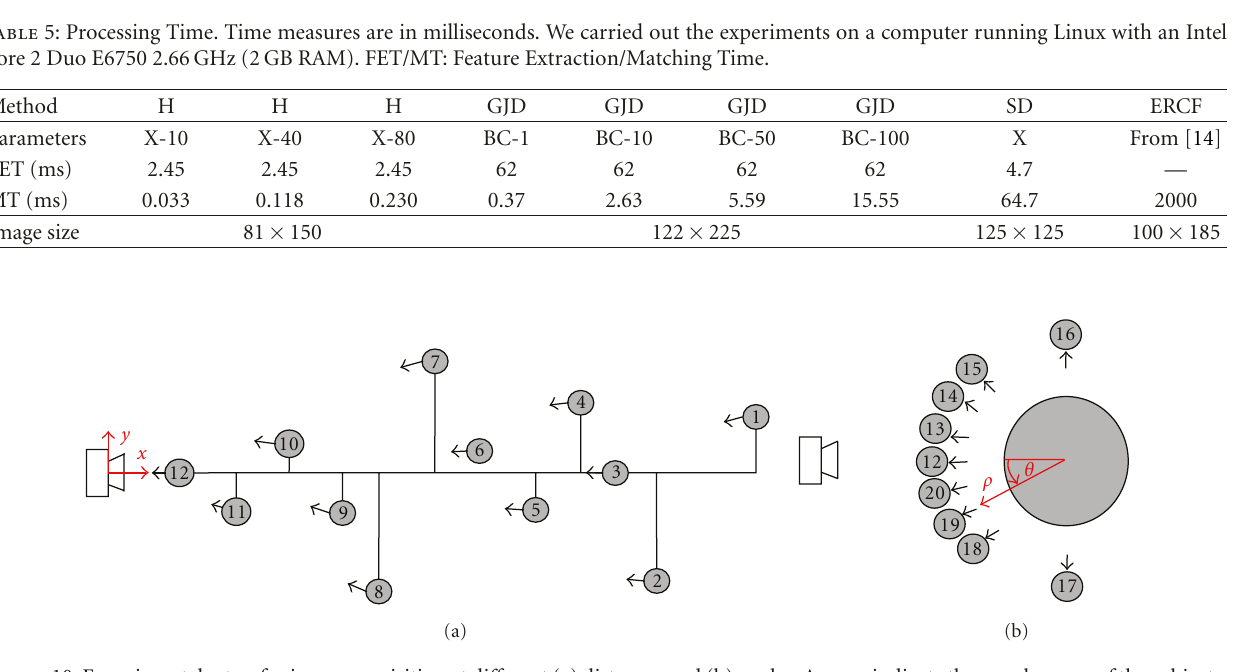
Figure 10: Experimental setup for image acquisition at di ff erent (a) distances and (b) angles. Arrows indicate the angular pose of the subjects. (a) Cartesian coordinates of acquisition points (in centimetres) relative to the camera’s focus: P1 (1088,90), P2 (906, − 180), P3 (785,0), P4 (755,151), P5 (665, − 51), P6 (574,30), P7 (514,181), P8 (423, − 181), P9 (332, − 61), P10 (272,30), P11 (181, − 61), and P12 (90,0). (b) Polar coordinates of acquisition points (radius in centimetres and angles in degrees) relative to the camera’s focus: P16 (90,90 ◦ ), P15 (90,45 ◦ ), P14 (90,30 ◦ ), P13 (90,15 ◦ ), P20 (90, − 15 ◦ ), P19 (90, − 30 ◦ ), P18 (90, − 45 ◦ ), and P17 (90, − 90 ◦ )